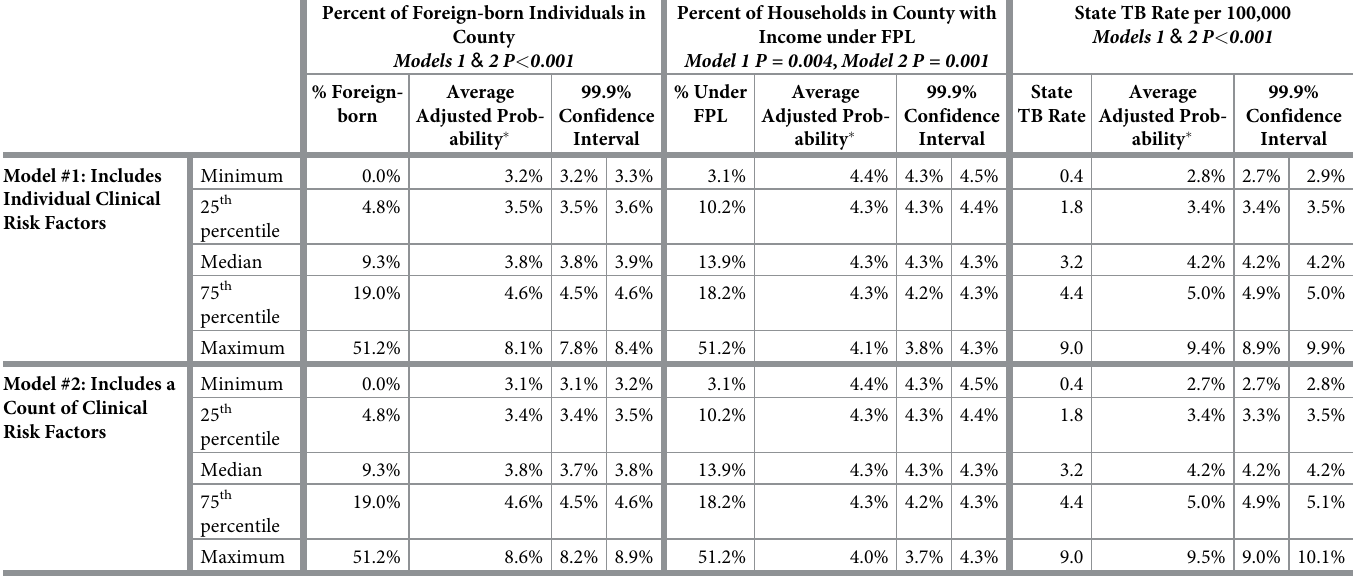
Table 4. Average adjusted probability of Mycobacteriumtuberculosis screening with either a tuberculin skin test (TST) or an interferon-gamma release assay (IGRA) at the minimum, maximum, and quartile values of the continuous variables included in the two logistic regression models detailed in Table 3. These models examine associations between insurance enrollee characteristics and screenings for M . tuberculosis between 2011 and 2013, based on data from the Optum Clinformatics Data Mart Database (N =